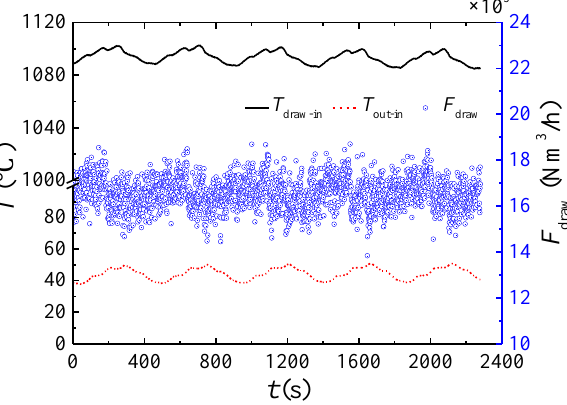
Figure 6. Monitoring data for the rate of hot gas withdrawal flow ( F draw ), the temperature difference between the hot gas withdrawal flow and inlet gas ( T draw-in ), and the outlet-inlet gas temperature difference ( T out-in ) during five cycles at F in = 105 × 10 3 Nm 3 /h, Y CH4,in = 0.94 vol %, and t c = 450 s.